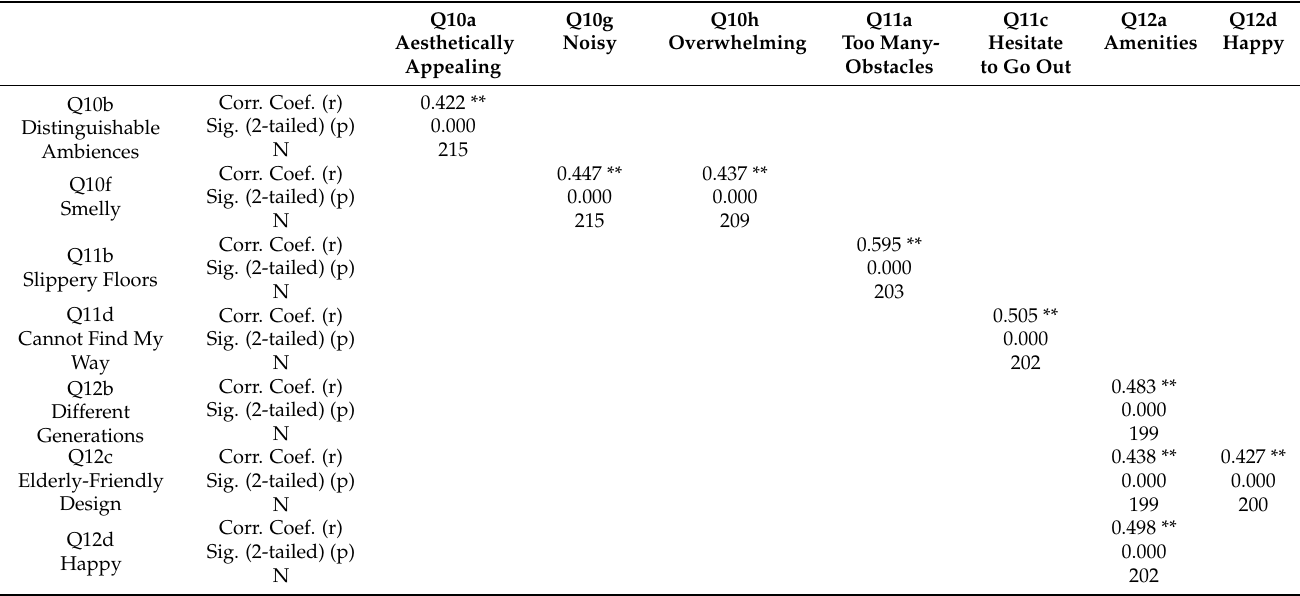
Table 15. Spearman correlation test: moderate correlations between different aspects of socio-perceptual assessment (Bangkit